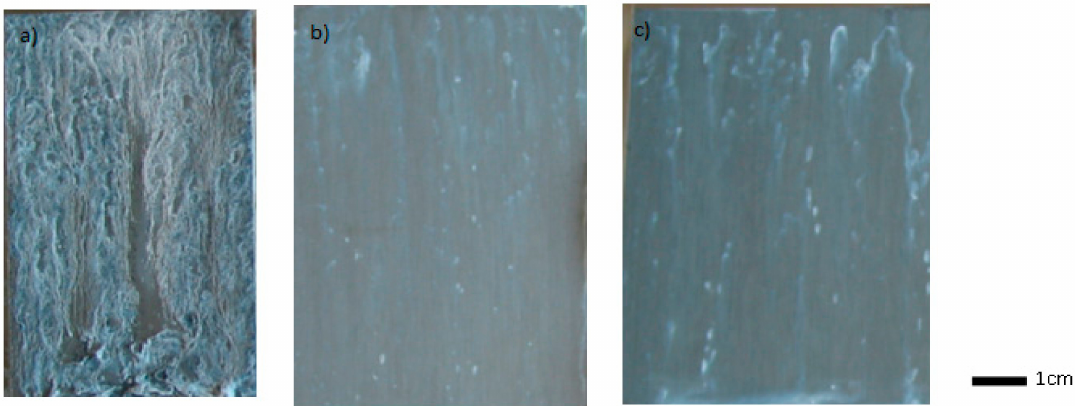
Figure 4. Salt spray test performed on ( a ) phosphated zinc for 24 h; ( b ) phosphated zinc + TEOS/MAP coating after 96 h; and ( c ) phosphated zinc + GPTMS/ASB coating after 96